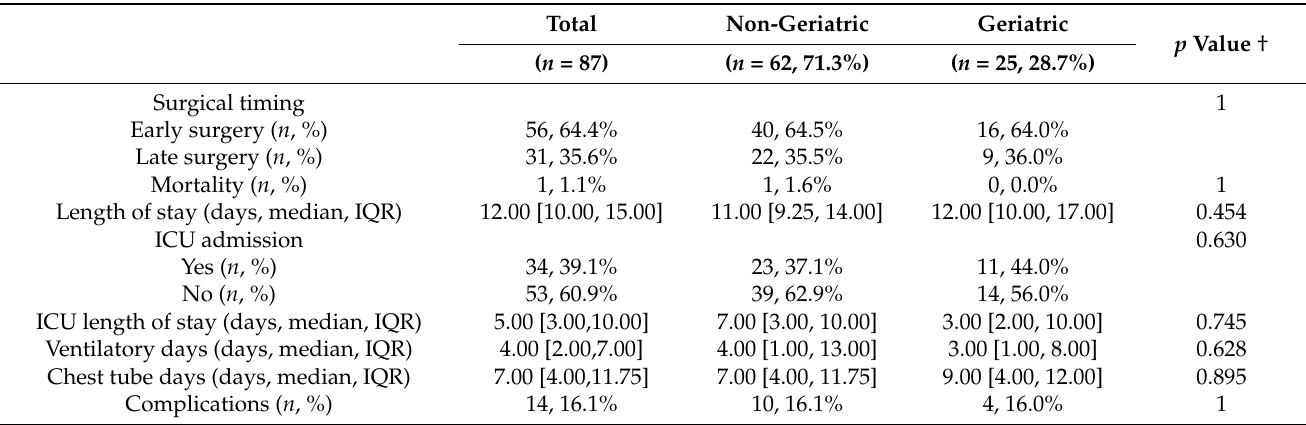
Table 2. The overall outcome of rib fracture fixation surgery in the geriatric and non-geriatric groups ( n = 87).